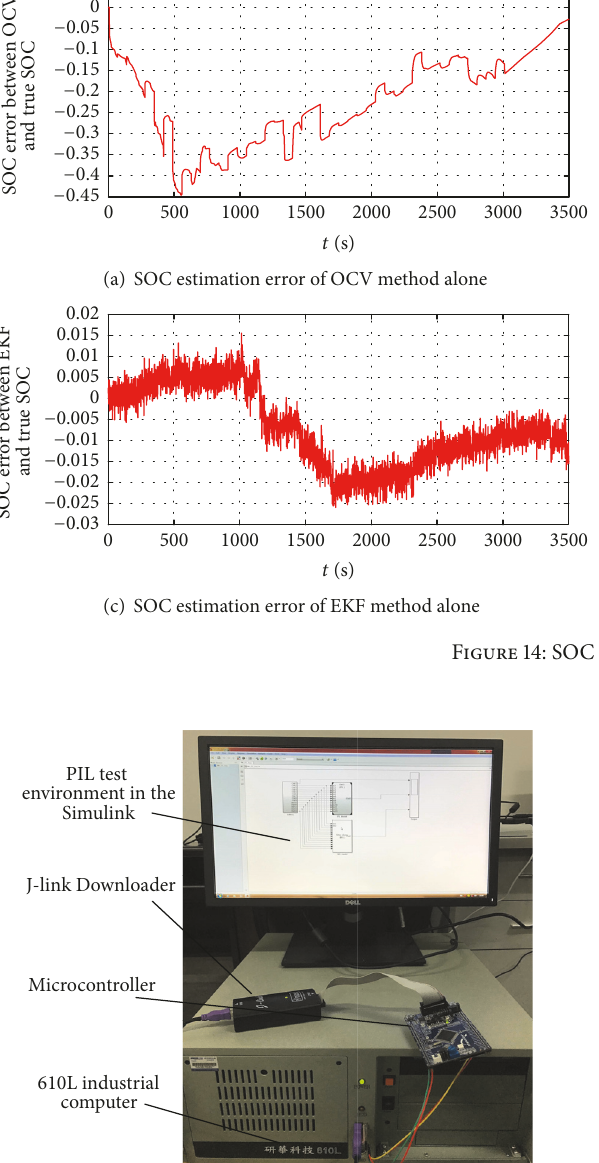
Figure 15: Processor-in-the-loop test platform.